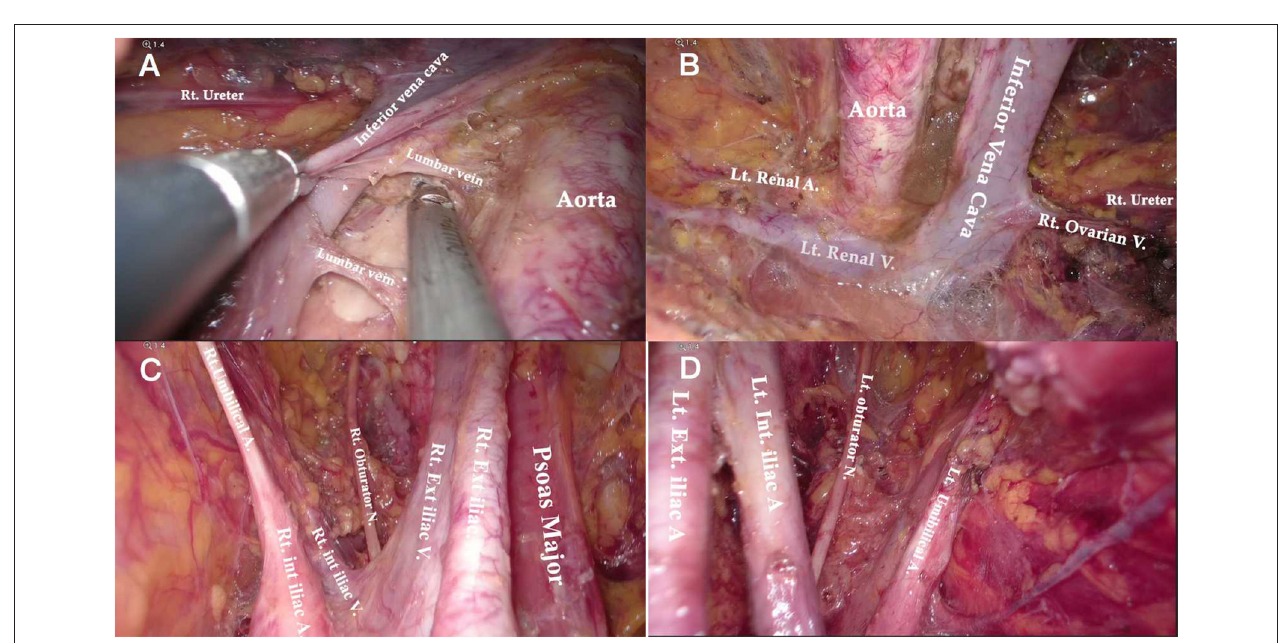
FIGURE 7 | Anatomical overview of para-aortic area. (A) Lymphadenectomy up to the left renal vein. (B) The right para-aortic region. (C) Dissection of the interaortocaval and retrocaval lymph nodes. (D) The infrarenal region after PALN.